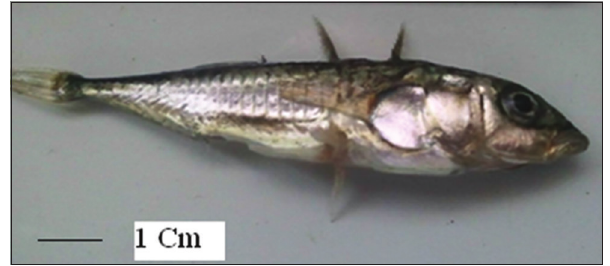
Figure-1: A male Gasterosteus aculeatus fish infected with Corynosoma caspicus from Caspian Sea; Note the dorsal spines on the body (scale bar: 1 cm).